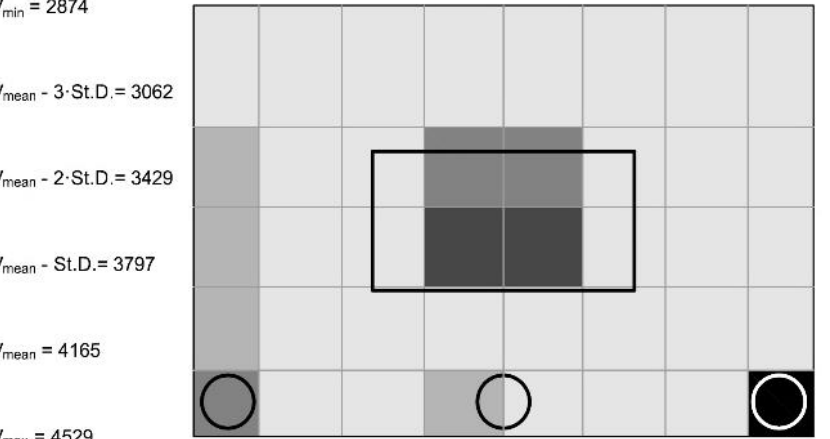
Figure 6. Map 4: Grid D. Levels of velocity.